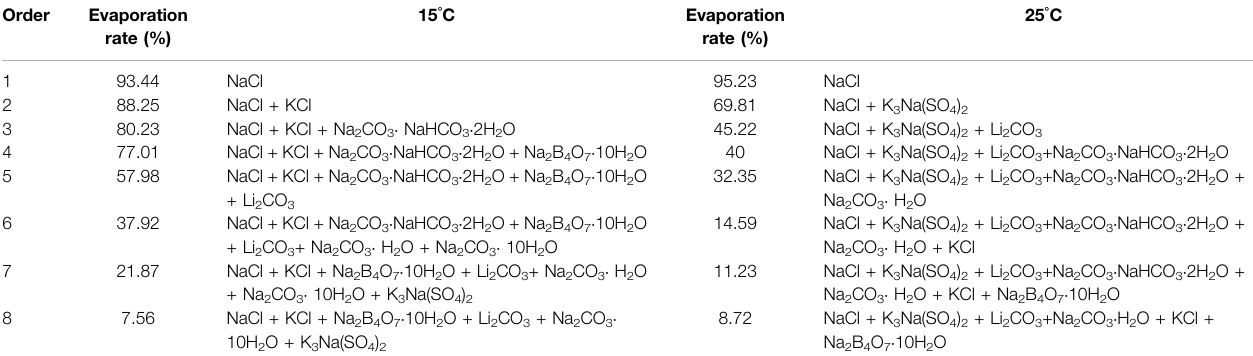
TABLE 2 | Salt minerals formed by isothermal evaporation of brines taken from Zabuye Salt Lake. Order Evaporation rate (%)